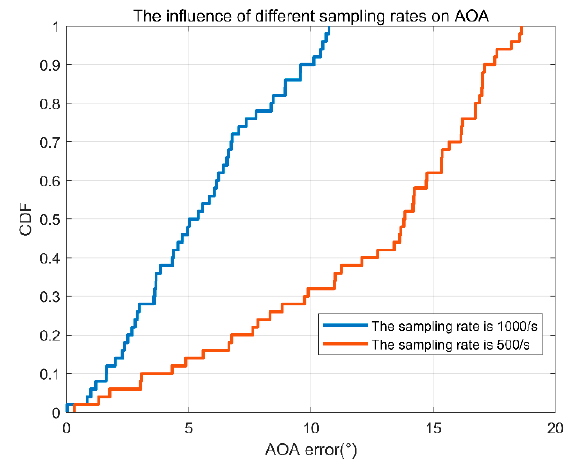
Figure 16. AOA error accumulation diagram of two different sampling rates. (4) Different shapes’